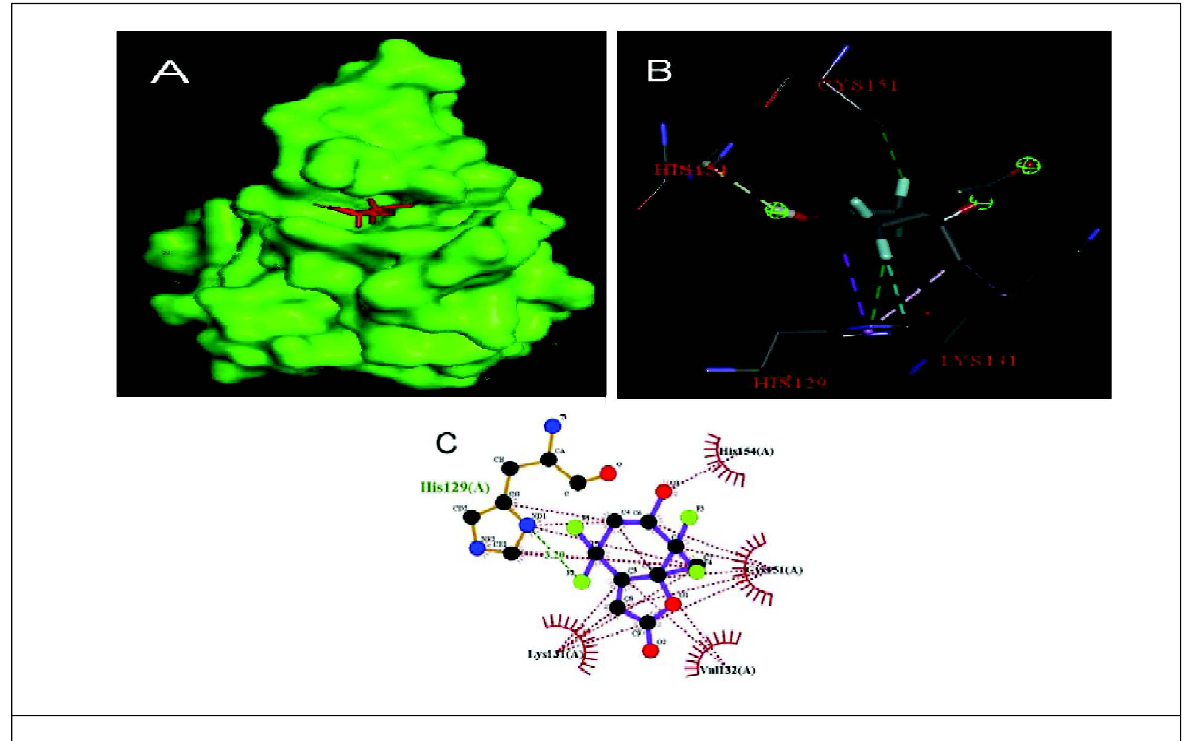
Figure 7: The pictorial illustrations for the Loliolide-5 derivative in the BTB domain (PDB: 5DAD), including the surface view of the top-ranked docked pose (A), interaction analysis from Accelrys Discovery Studio (B) and the same from LigPlot (C)